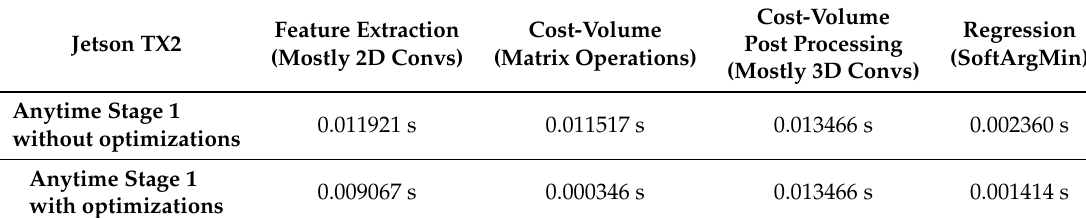
Table 5. Runtime performance of anytime stage 1 on Jetson TX2 with and without model